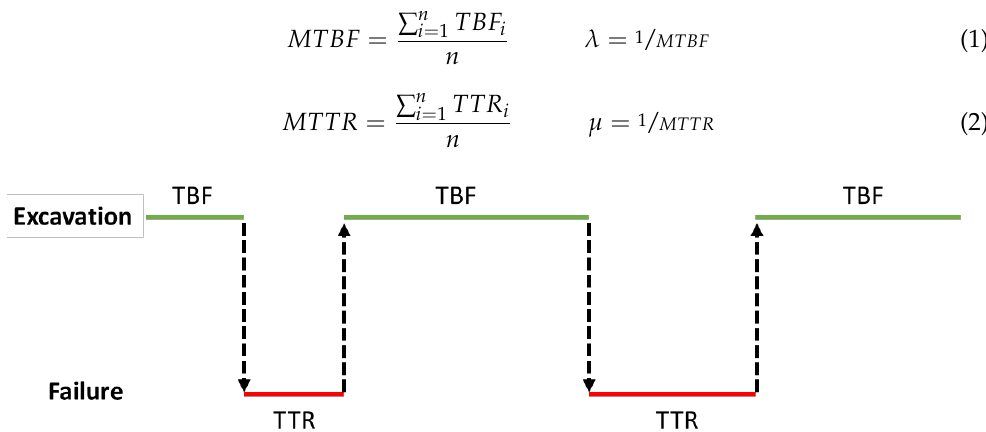
Figure 2. TBF and TTR of the machine for each subsystem.